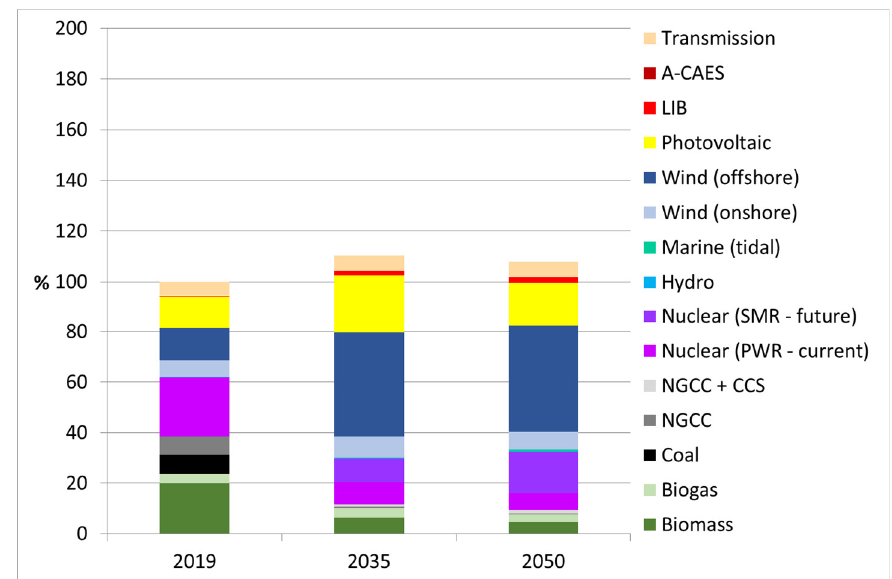
Figure 10. Human toxicity potential per unit of electricity delivered by the UK grid mix (including energy storage and transmission), expressed as relative to the 2019 value (100% = 83 g 1,4-DB-eq/kWh).